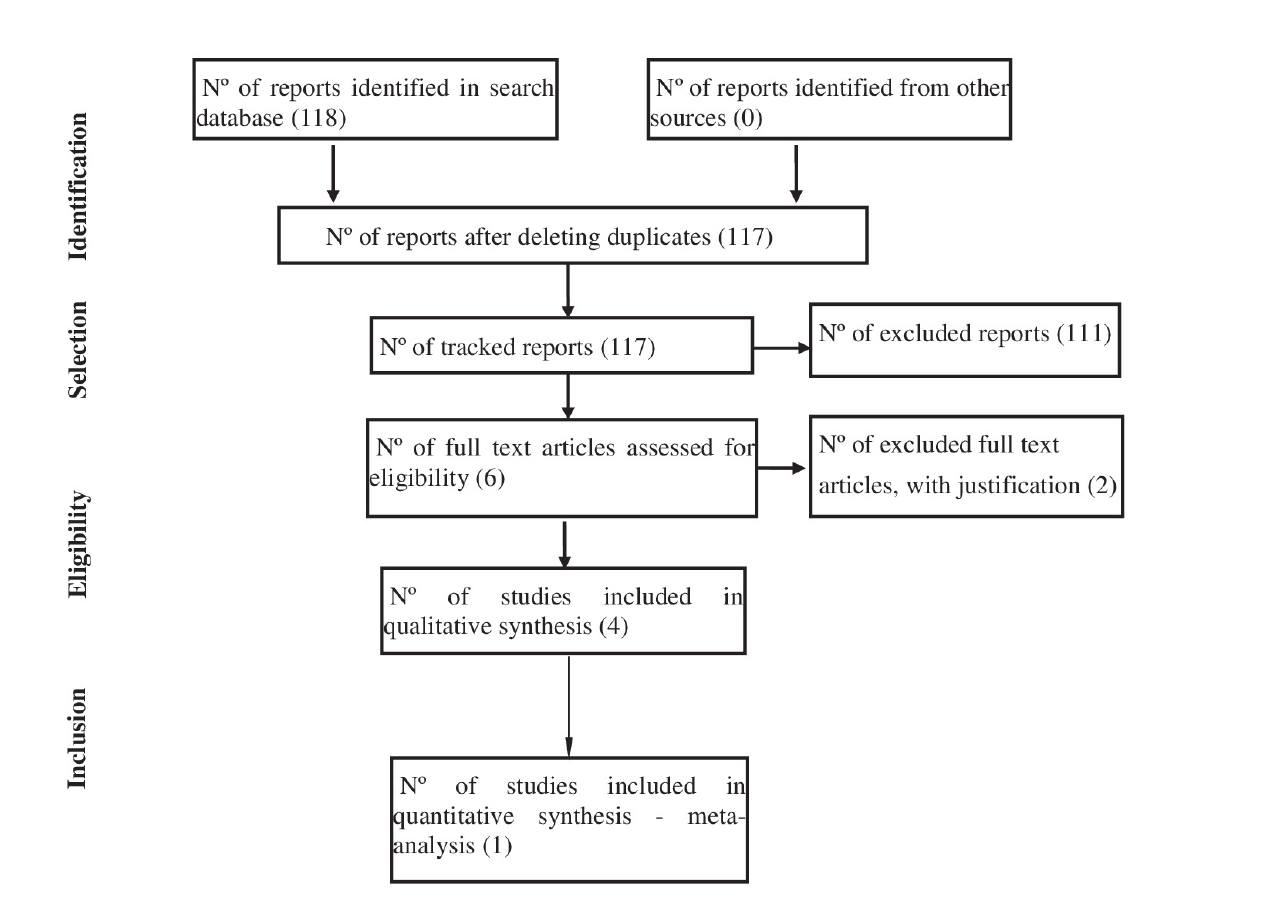
FIGURE 1 - Study selection flow